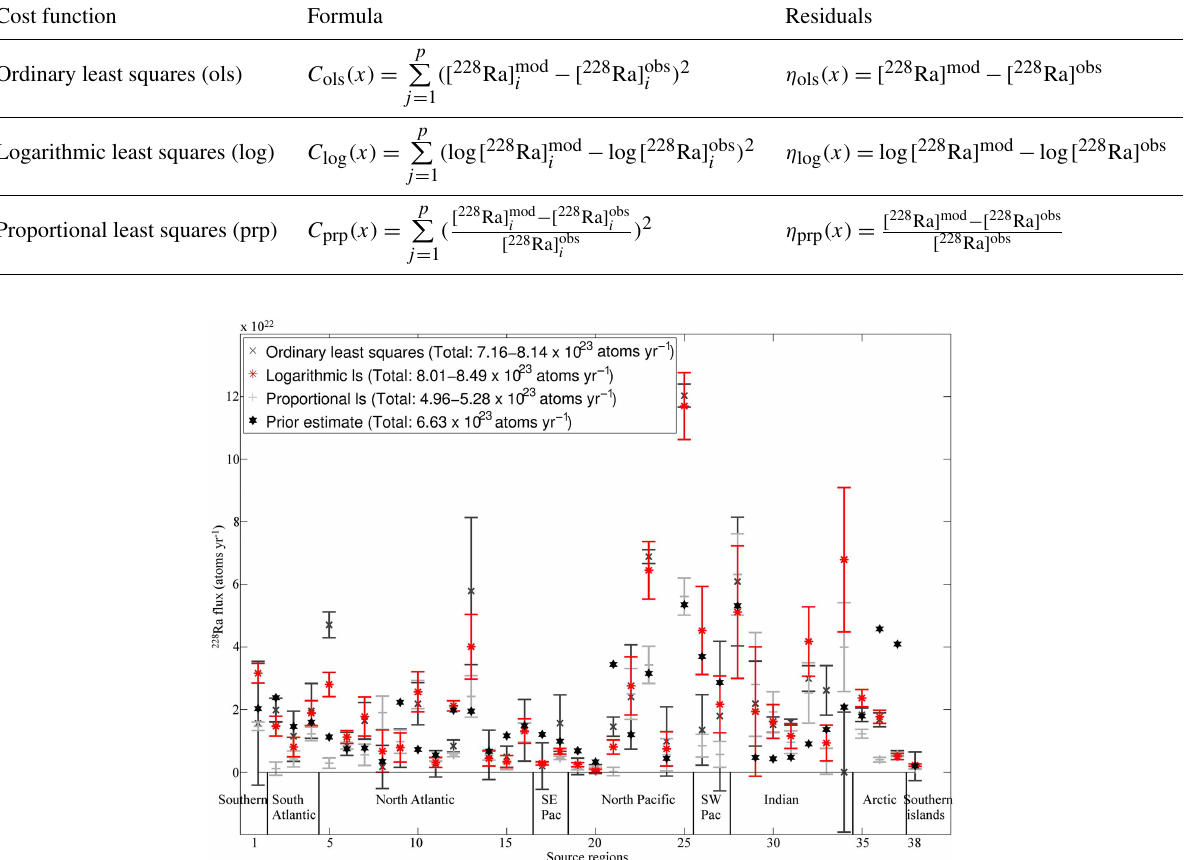
Figure 3. 228 Ra annual flux from each source within one standard deviation, after minimization of three cost functions. Prior estimates, proportional to shelf surfaces, are shown for